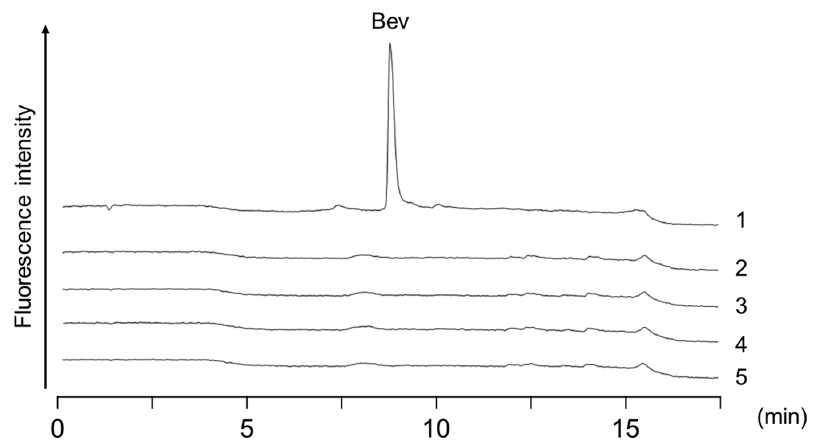
Figure 4. Chromatograms of 10 µ g/mL of five therapeutic mAbs treated after aptamer affinity purification using anti-bevacizumab DNA aptamer. Chromatograms: 1. bevacizumab; 2. trastuzumab; 3. infliximab; 4. nivolumab; 5. tocilizumab.